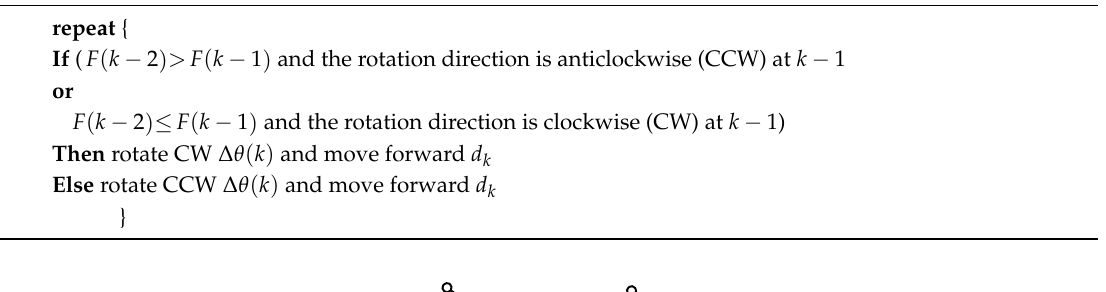
Algorithm 1: The choice mechanism of the turning direction